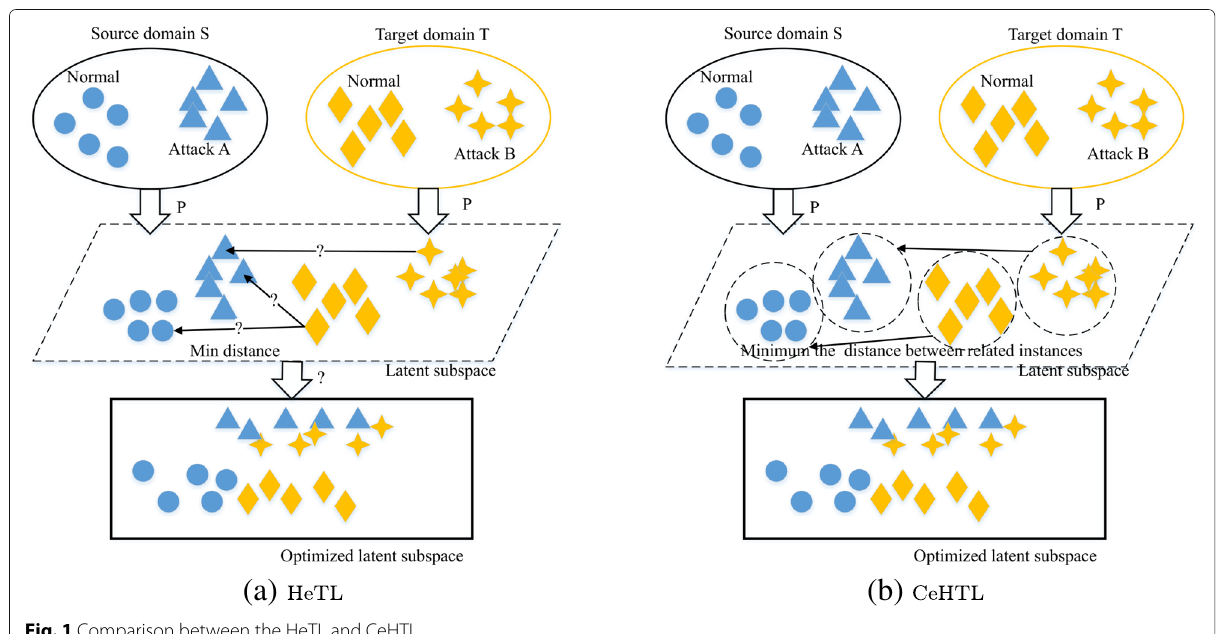
Fig. 1 Comparison between the HeTL and CeHTL